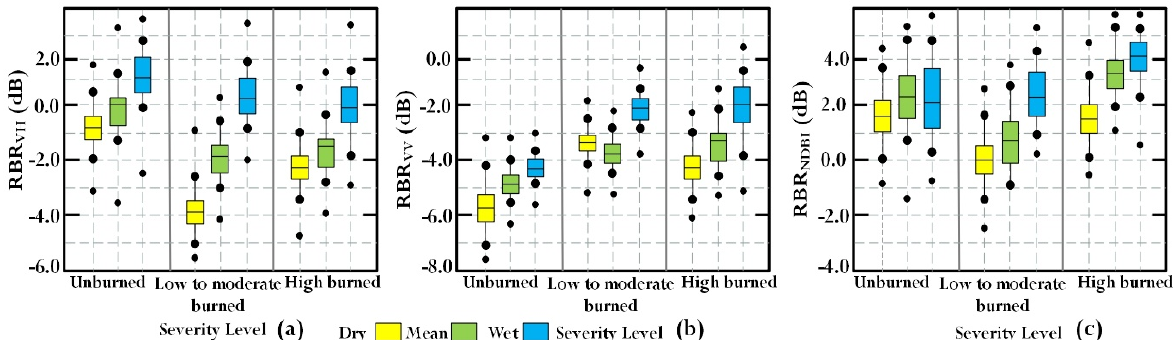
Figure 4. The relationship between RBR and intensity levels under various environmental conditions for VH polarization ( a ), VV polarization ( b ), and NDBI ( c ). Median values (horizontal line), percentiles (25% and 75%, box edges), non-outlier values range (whiskers), and outlier values (circles) are seen in box plots.